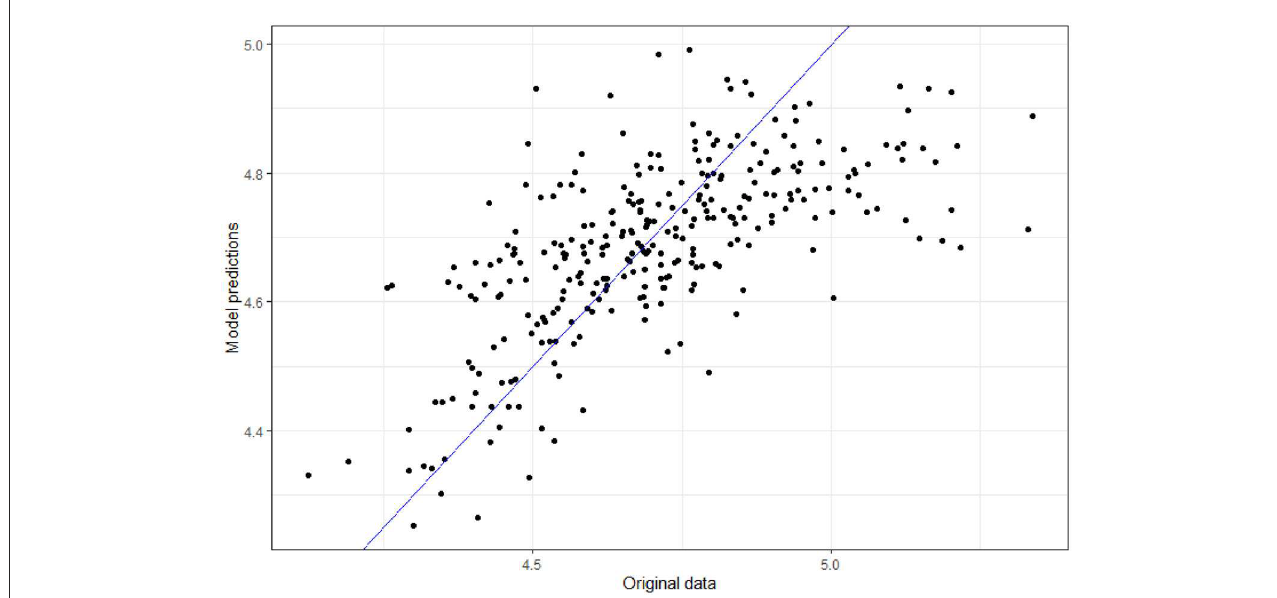
FIGURE8 Validation of the final model: The same model specification was fit on a random 80% subset of the original data, that model being used to generate predictions for the remaining 20%, plotting those predictions against actual data. R 2 = 0.67.